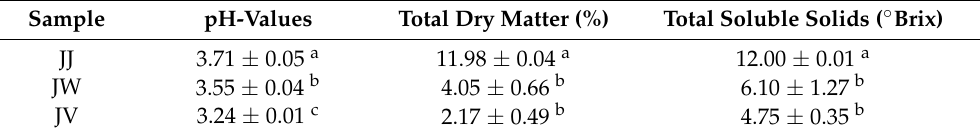
Table 2. Chemical contents of jujube juice (JJ), jujube wine (JW) and jujube vinegar (JV).